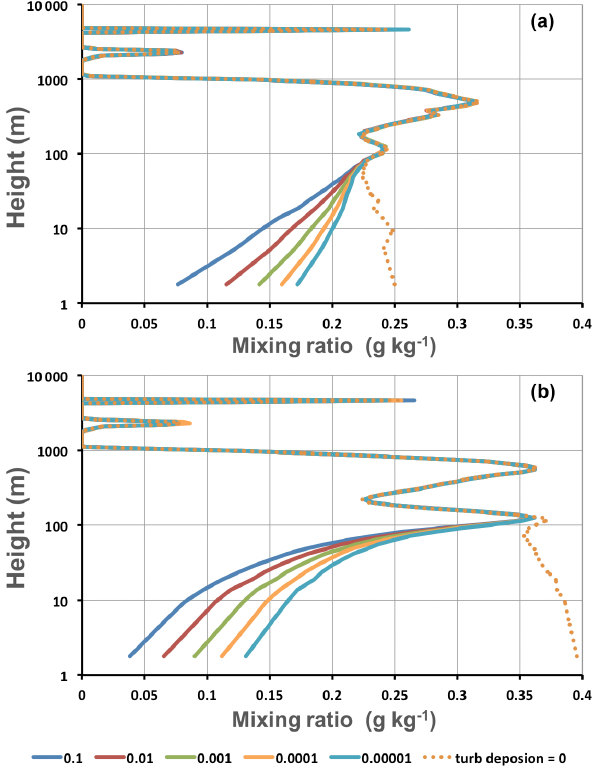
Figure 3. (a) Potential temperature ( θ ) and (b) Q v profiles corre- sponding to Fig. 2, including the initial profiles. Note that the z 0c deposition of cloud droplets has minimal impact, and all curves are overlain.